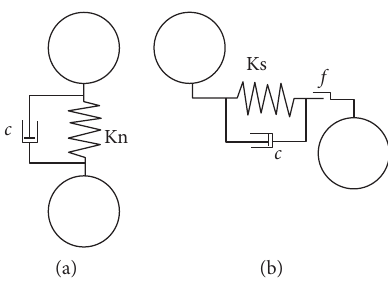
Figure 2: Rheological components of the force-displacement law between two particles.